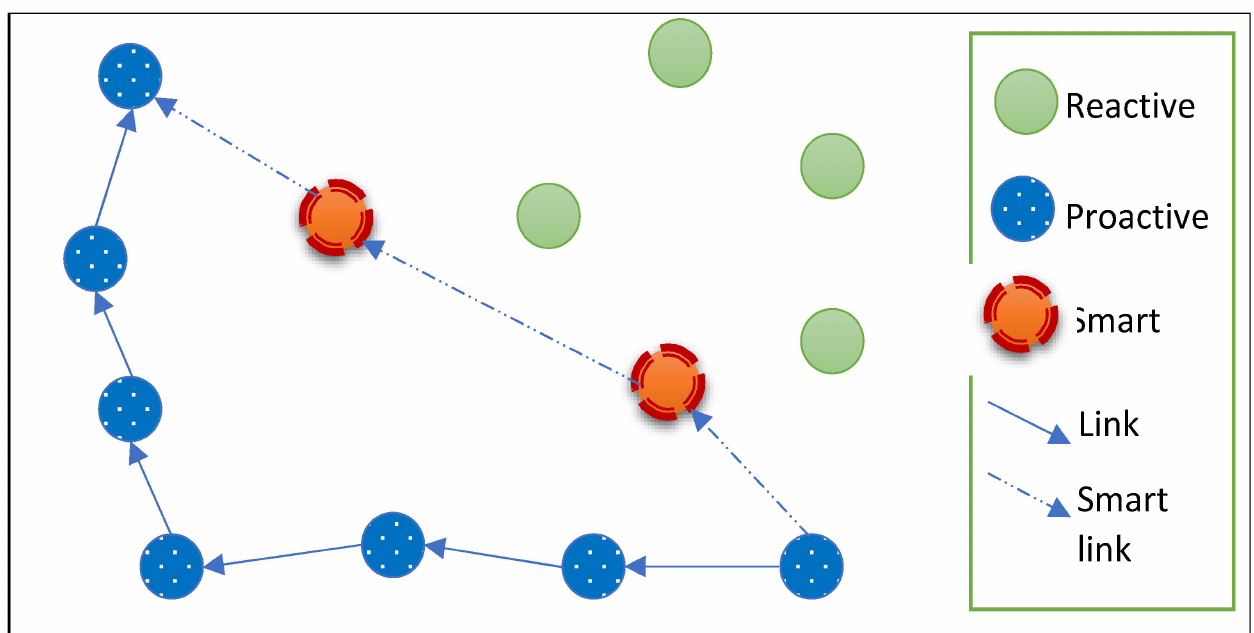
Figure 5. Nodes from the same class are deployed in an L form.